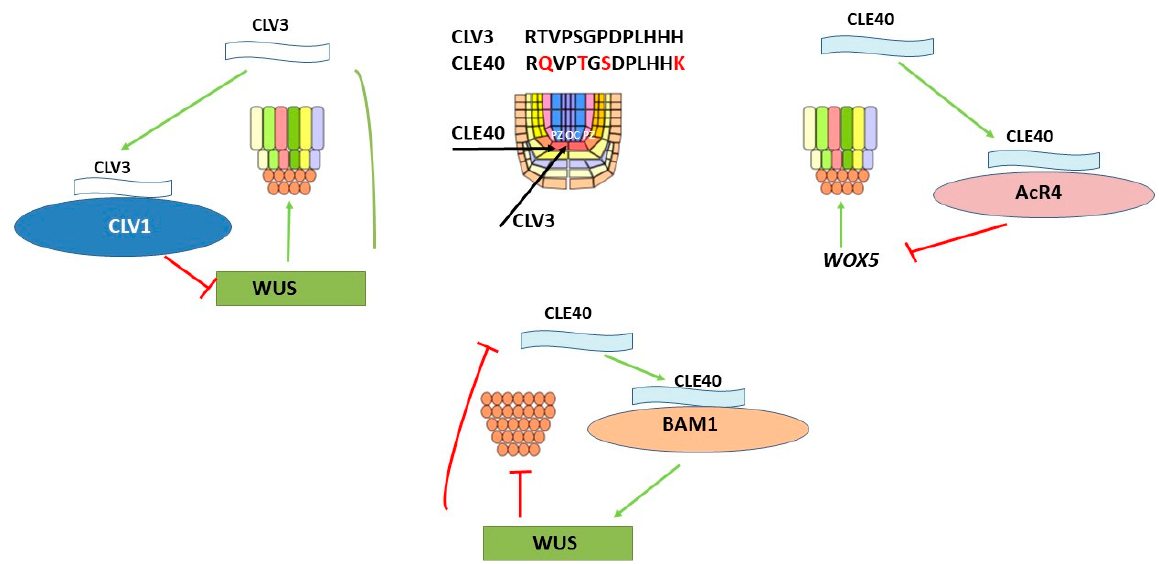
Figure 4. CLV3 peptide forms a negative feedback loop CLV3-CLV1-WUS in RAM; the CLE40 peptide forms a negative feedback loop CLE40-AcR4-WOX5 in RAM; the CLE40 peptide forms a negative feedback loop of CLE40-BAM1-WUS in SAM.